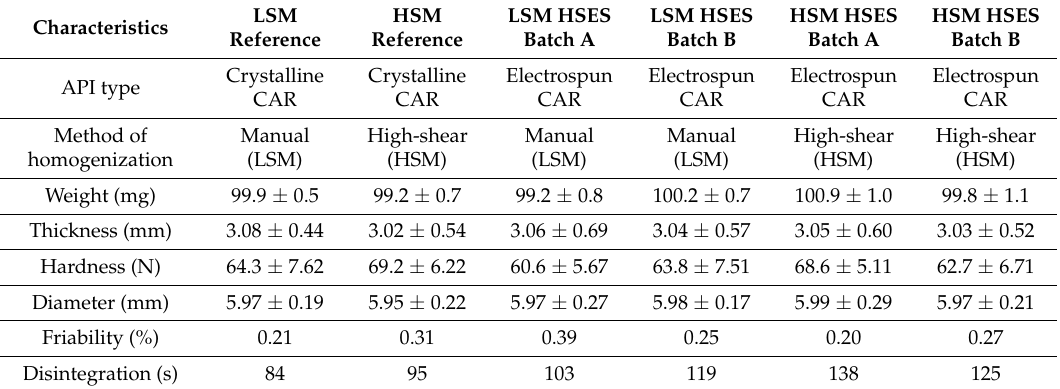
Table 3. Batch characteristics and their IPC results (A and B are repetitions of the same